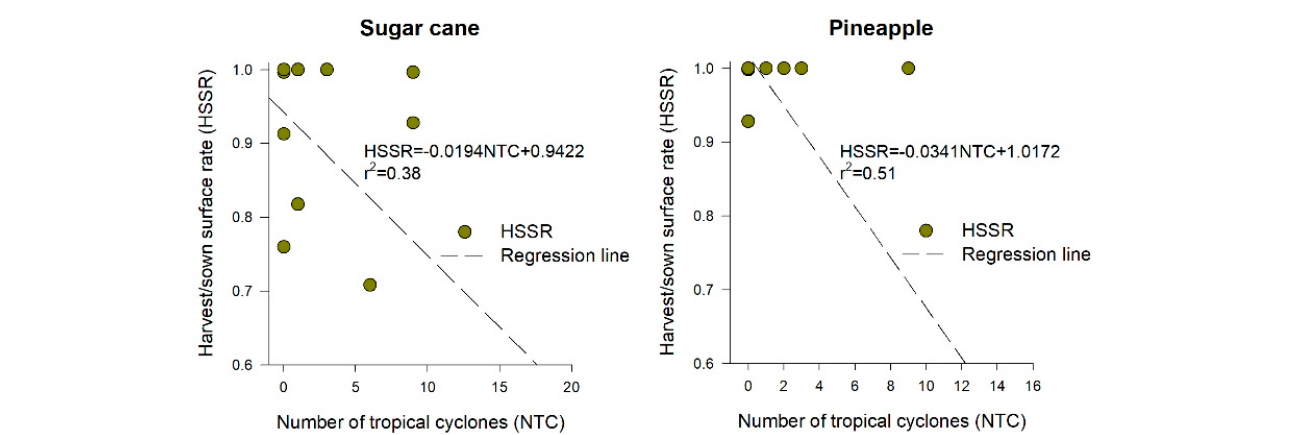
Figure 12. Regression lines and linear equations predicting the relationship between the harvested over sown surface rate with the most adverse hydrometeorological phenomenon for the five most valuable crops in the State of Veracruz. R 2 indicates the coefficient of determination.